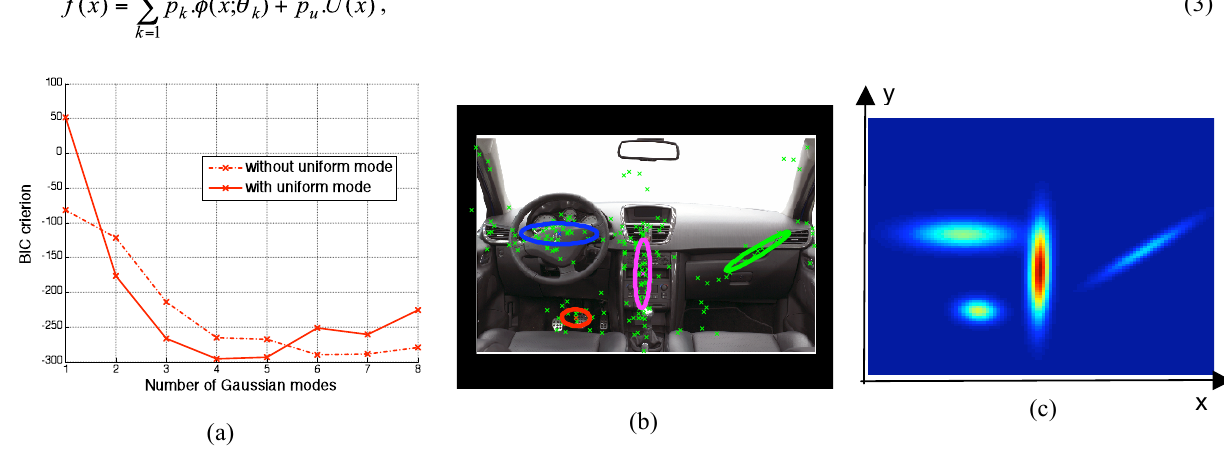
Figure 2: (a) Evolution of the BIC for all the K candidate values for the two models, with or without the uniform mode (b) Eye fixations during a free viewing of this scene and localization of the Gaussian modes, after the model selection, (c) Spatial density f(x, y) of the eye fixations, after the model selection. Four Gaussian modes are then defined to best fit the experimental data. The contribution of the uniform mode is not visible on the figure because its density is